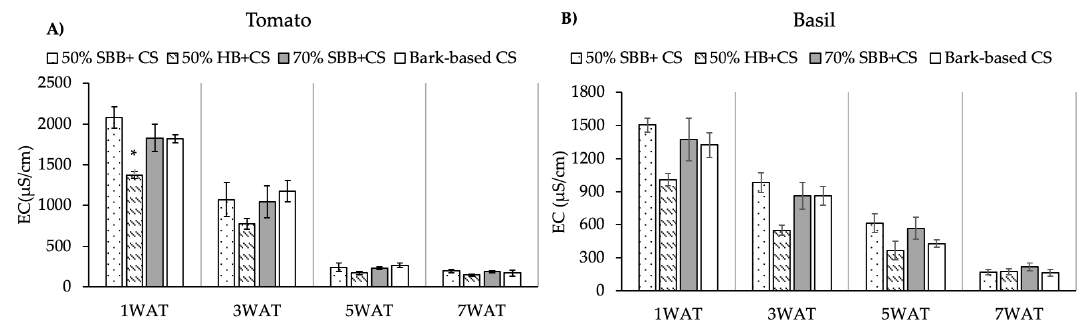
Figure 1. The EC (mean ± standard error) of potting mixes with 50% sugarcane bagasse biochar (SBB), 50% mixed hardwood biochar (HB), and 70% SBB (by vol.) mixed with bark-based commercial substrate (CS) with tomato ( A ) and basil ( B ) plants at 1, 3, 5, and 7 week(s) after transplanting ( WAT). *indicated significant differences from CS using Dunnett’s test at p ≤ 0.05.